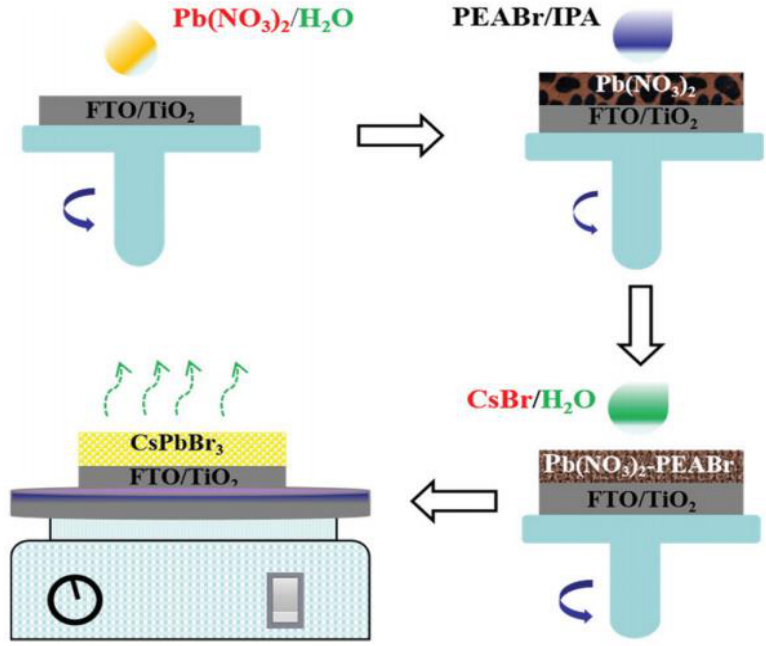
Figure 11. Schematic diagram of the eco-friendly fabrication process of CsPbBr 3 films [64]. Another method is to find a green or green-mixed solvent to replace DMF to dissolve PbBr 2 . Wei’s group [65] adopted all-green solvents based on a two-step spin-coating method to make CsPbBr 3 films, in which a green mixed solvent of γ -butyrolactone and polyethylene glycol (PEG) is used to dissolve PbBr 2 in the first step and green water to dissolve CsBr to prepare CsPbBr 3 PSCs with a PCE of 8.11%. The highest PCE of the all- green solvent system of CsPbBr 3 PSCs, in which polyethylene glycol played a solubilizing effect, was 8.11%. After 30 days of air storage, the device’s PCE still exhibit ed performance similar to that of the original value, demonstrating the excellent stability of CsPbBr 3 -based solar cells. Generally speaking, PbBr 2 has low solubility in commonly used green solvents. The solubility of PbBr 2 in triethyl phosphate (TEP) is 60 mg/mL [32], which is much lower than the solubility of PbBr 2 in DMF. Thus, Wei ’s [32] group developed an anomalous sequential deposition method to make CsPbBr 3 films, as shown in Figure 12, in which the CsBr solu- tion is prepared using a green solvent system made of water, suitable ethanol, and eth- ylene glycol (EG), and the PbBr 2 solution by using a green TEP. In contrast to the conven- tional sequential deposition method, CsBr solution is first deposited in the first step, and then reacted with PbBr 2 . In this anomalous sequential deposition method, the cells exhibit a PCE of 6.86%, which is equivalent to the PSCs prepared using toxic solvents. Moreover, the PCE of the device shows a comparable value to the initial value when the device was kept in air for 14 days with 40% RH and at 30 °C, displaying the outstanding stability of CsPbBr 3 solar cells. Figure 12. Schematic image of the fabrication process of CsPbBr 3 films through an anomalous route using all-green solvents [32].